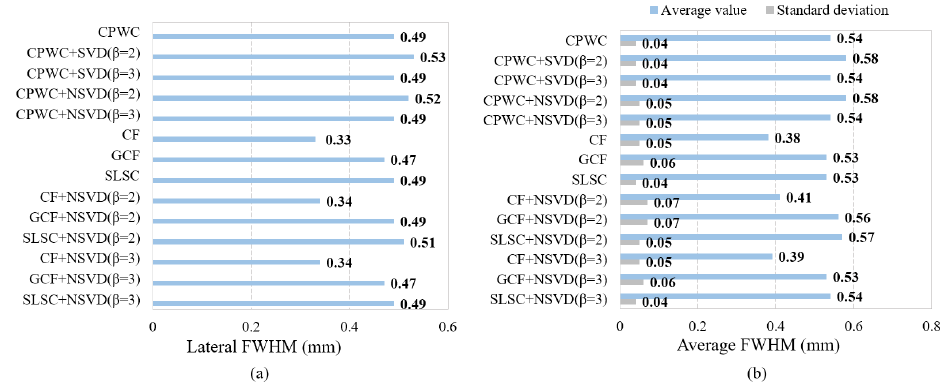
Figure 10. Lateral FWHM in experimental images: ( a ) p 1 ( x , z ) = ( − 0.4 mm, 18 mm), ( b ) average values and standard deviation of all point